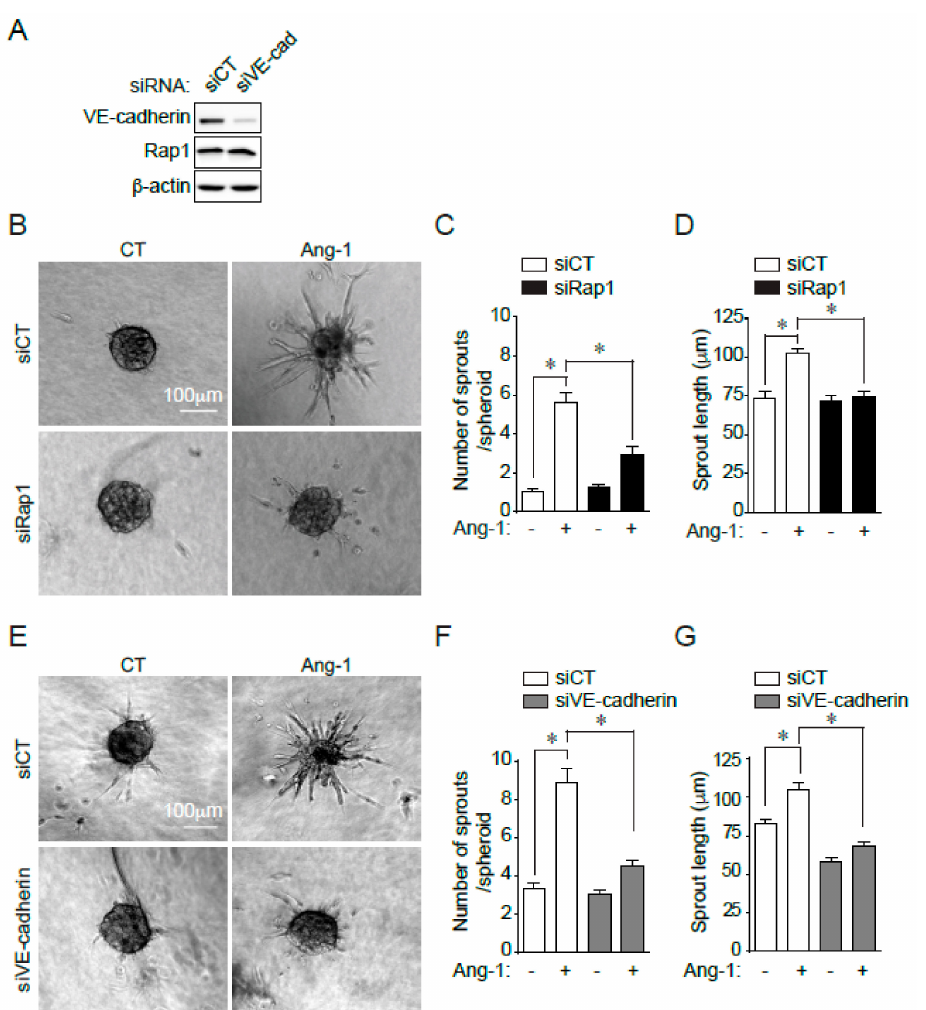
Figure 3. Rap1 and VE-cadherin required for Ang-1-induced BAEC sprouting. ( A ) SiRNA-mediated downregulation of VE-cadherin in BAECs. BAECs were transfected with control siRNA (siCT) or targeting VE-cadherin (siVE-cadherin), and downregulation was confirmed by immunoblotting against VE-cadherin. Rap1 and β -actin were used as loading controls. ( B ) Representative images of phase-contrast micrographs of BAEC spheroids transfected with control siCT or targeting Rap1 (siRap1) and treated with Ang-1 (100 ng / mL) or left untreated (CT). ( C , D ) Quantification of number of sprouts per spheroid and sprout length. Data presented as mean ± SEM of three experiments with at least eight spheroids per condition. Scale bar represents 100 µ m. ( E ) Representative images of phase-contrast micrographs of BAEC spheroids transfected with siCT or siVE-cadherin and treated with Ang-1 (100 ng / mL) or left untreated (CT). ( F , G ) Quantification of number of sprouts per spheroid and sprout length. Data represented as mean ± SEM of three experiments with at least eight spheroids per condition. Scale bar represents 100 µ m; * p <